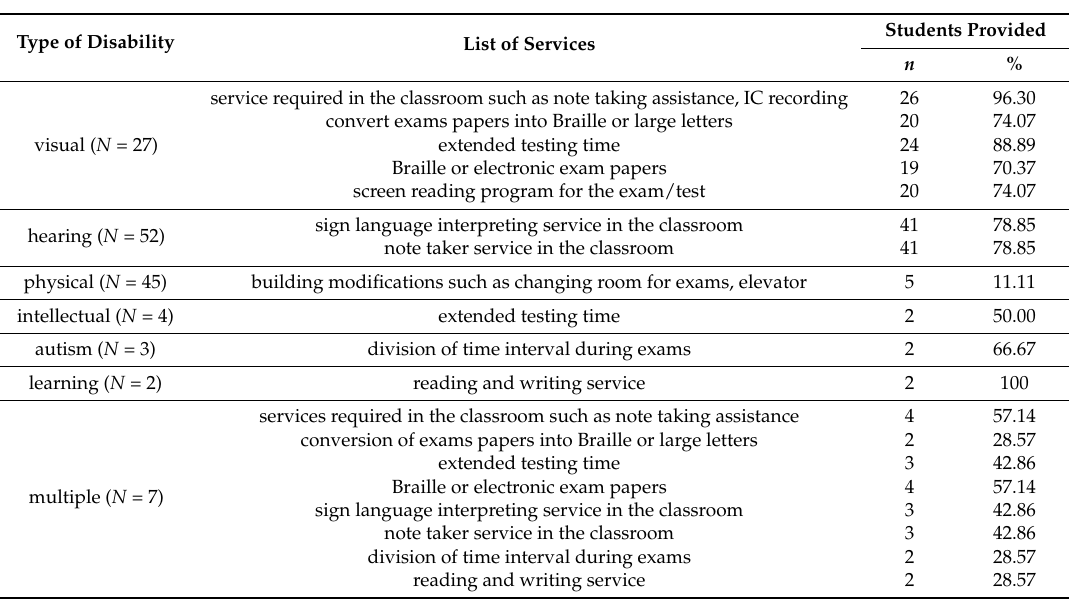
Table 6. Educational services based on the concept of universal